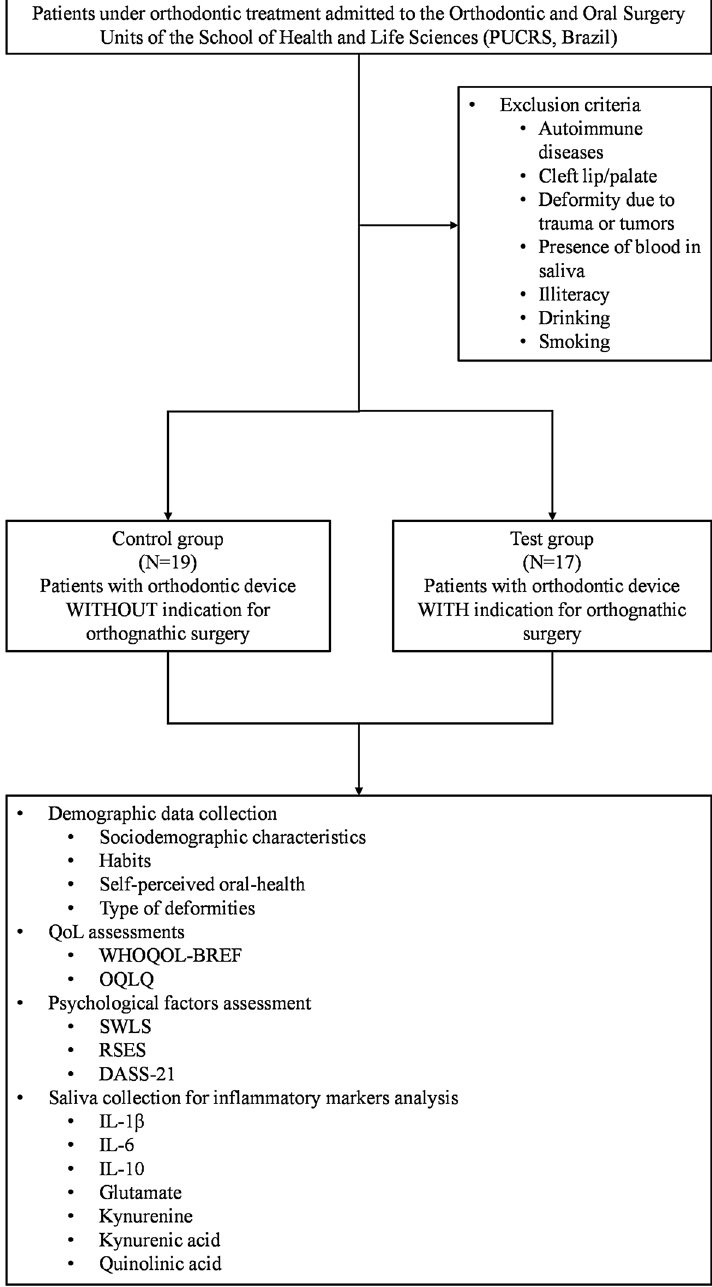
Figure 4. Flowchart of the Study Design. The patients undergoing orthodontic treatment that were admitted to the Orthodontic and Oral Surgery Units of the School of Health and Life Sciences (PUCRS, Brazil) were recruited for this study. The eligible patients were allocated into two different groups, according to the need for OS. Afterward, the participants answered sociodemographic, QoL, and psychological factors questionnaires. Saliva was collected for the analyses of the inflammatory